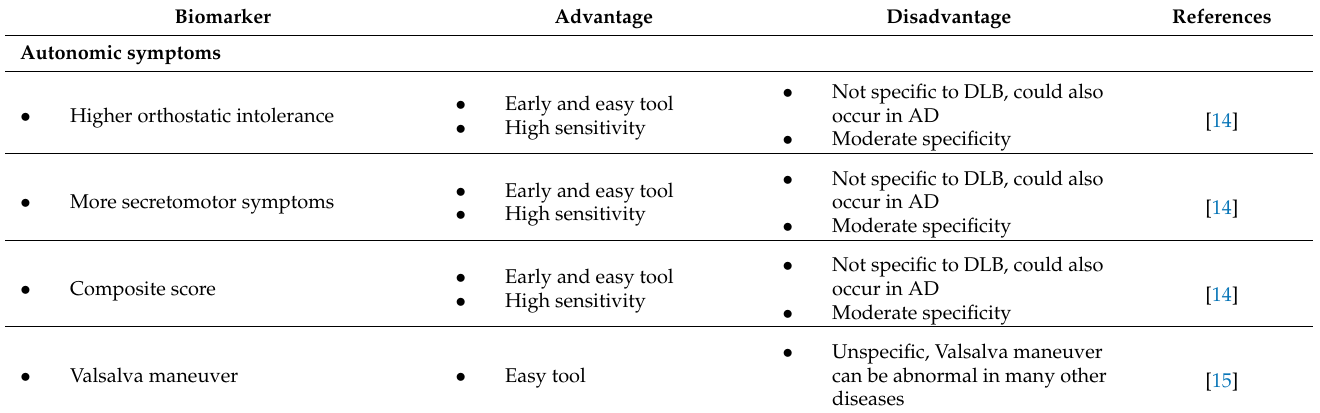
Table 1. Critical appraisal of different novel biomarking strategies for prodromal DLB with MCI onset.